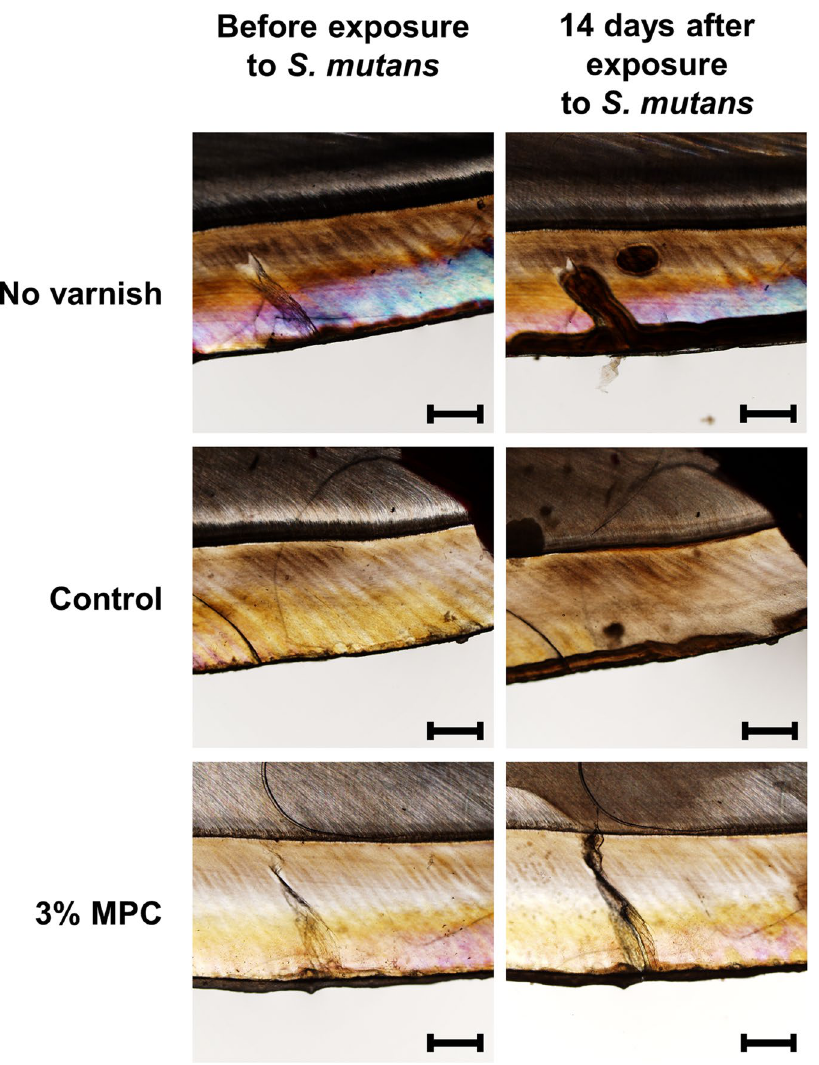
Figure 6. Representative polarized light microscopy images of a bovine tooth before and 14 days after exposure to BHI culture medium supplemented with 2% sucrose and bacterial inoculum. Specimens were treated with 0% MPC-LCFV (control), 3% MPC-LCFV, or no varnish. Scale bar is 500 µ